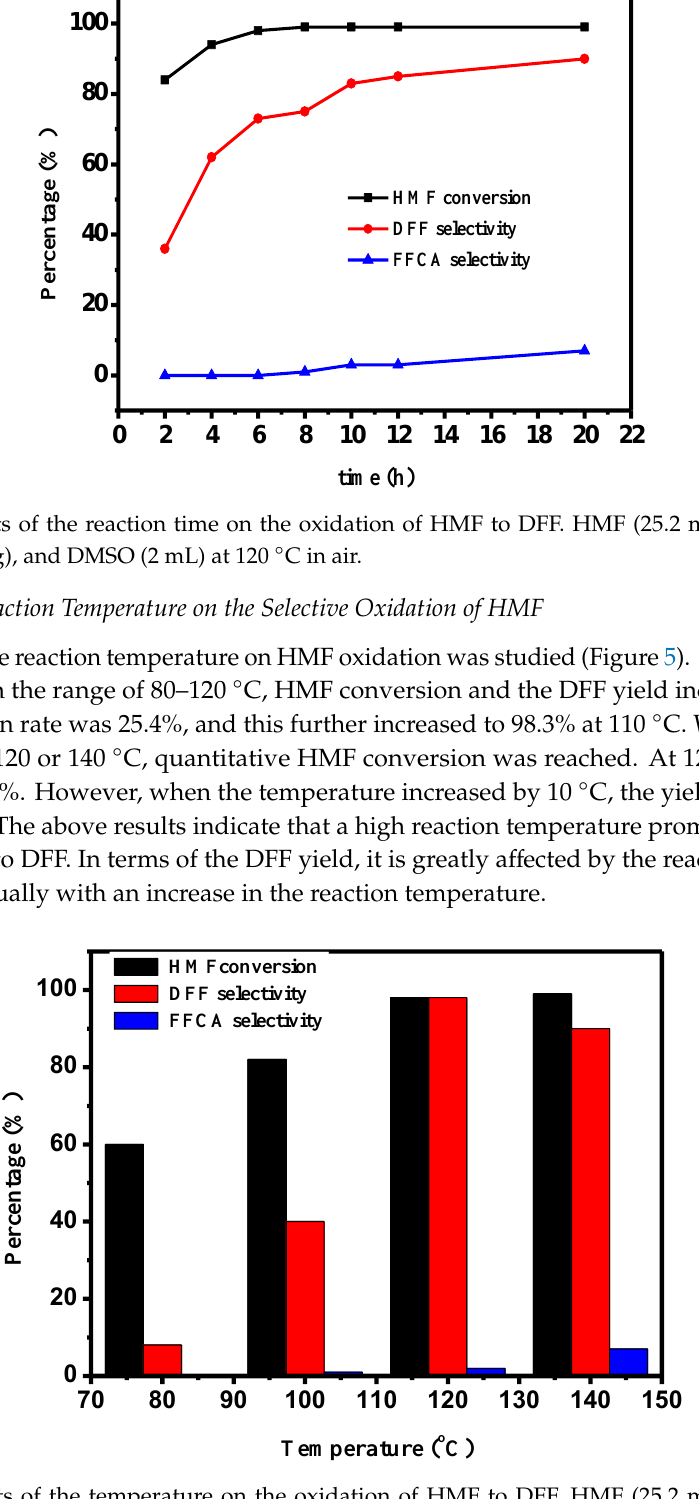
Figure 5. E ff ects of the temperature on the oxidation of HMF to DFF. HMF (25.2 mg, 0.2 mmol), VPO / P-C (10 mg), and DMSO (2 mL) for 10 h in air.